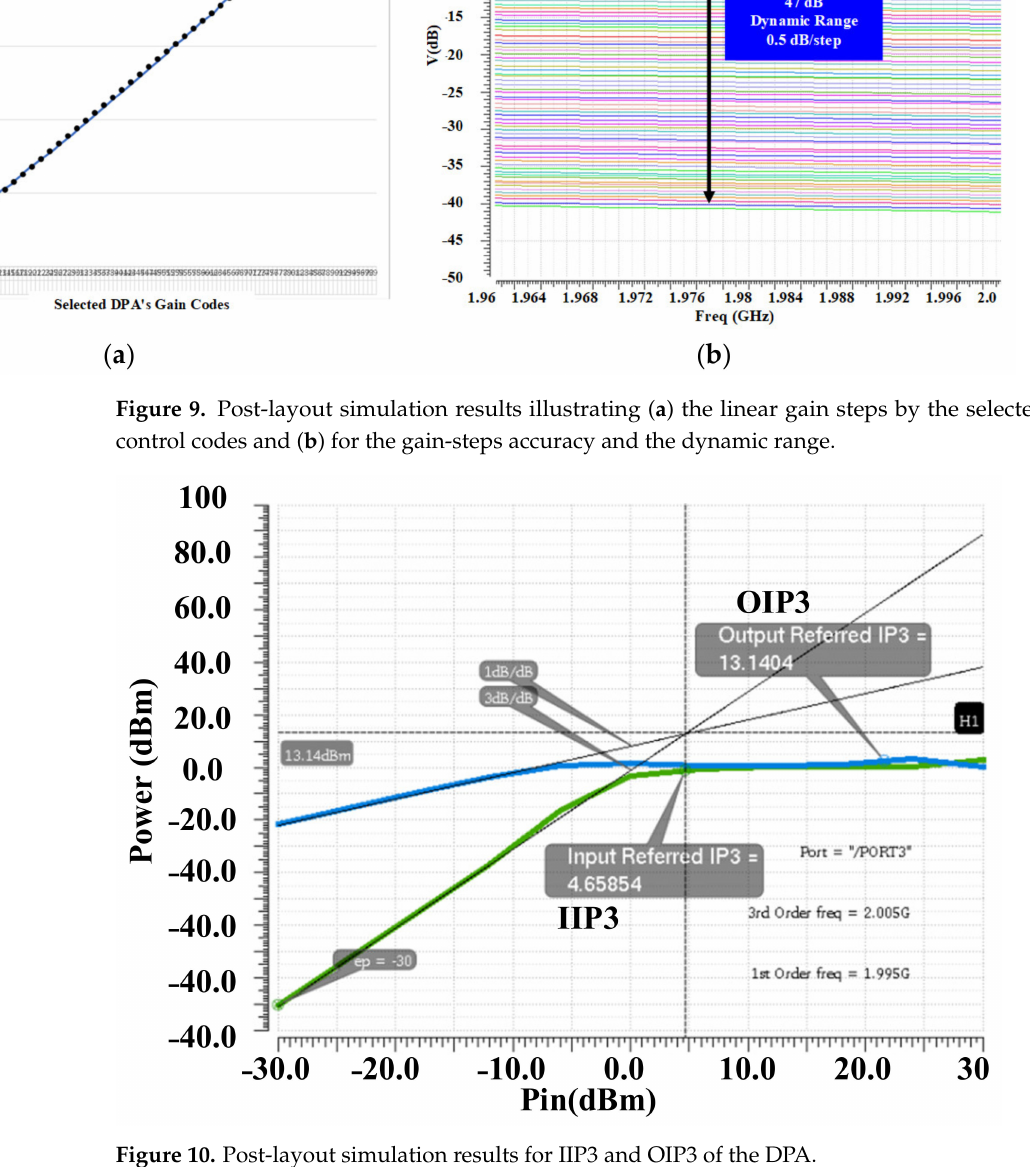
Figure 10. Post-layout simulation results for IIP3 and OIP3 of the